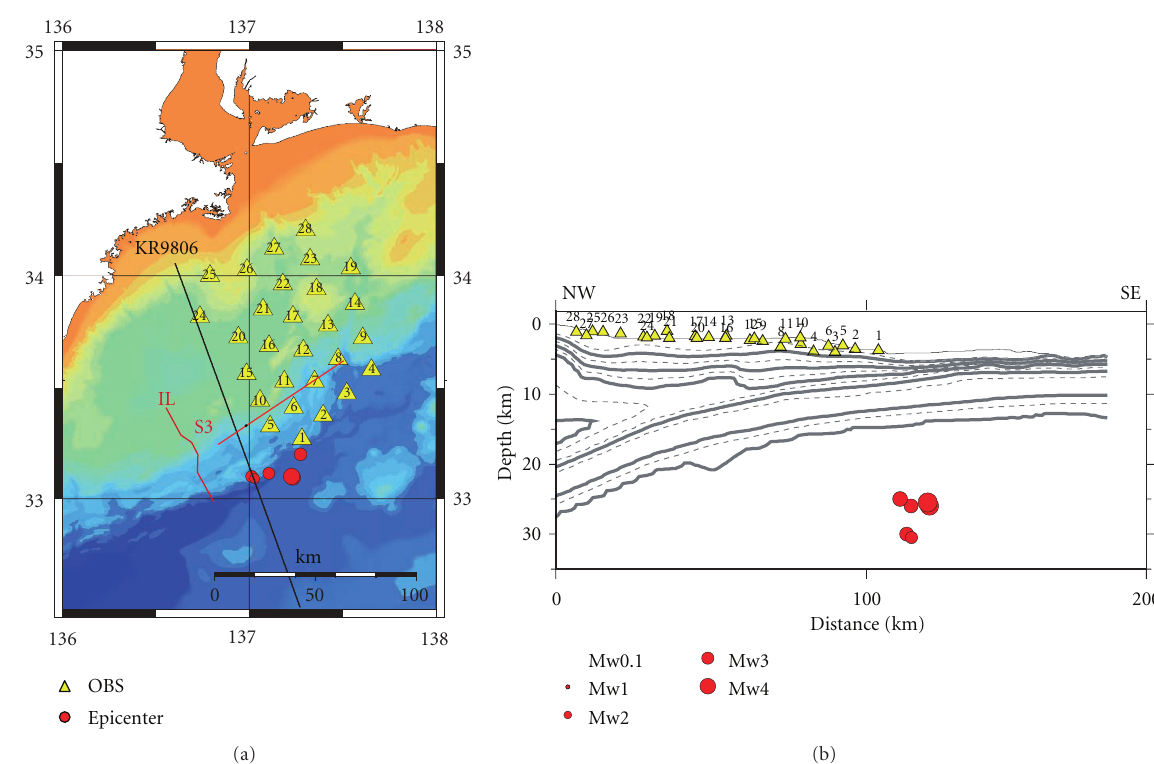
Figure 9: (a) Survey area in the Nankai Trough. Three seismic survey lines, KR9806, IL, and S3 indicate those from Figure 9(b) [8], Figure 11(a) [9], and Figure 13(c) [10], respectively. (b) The depth of OBS and earthquakes projected to the line KR9806. Background velocity contour is derived from refraction tomography [8]. The hypocenters associated with 6 earthquakes are localized around the trough